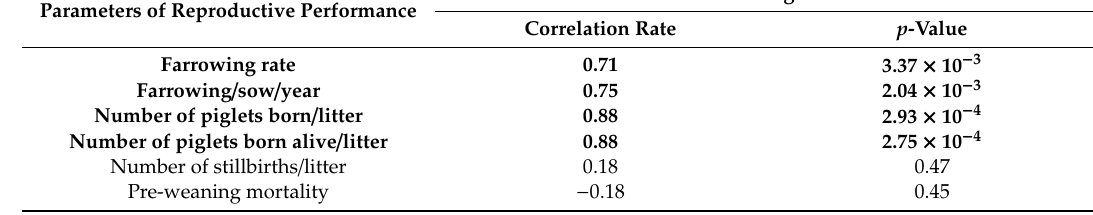
Table 2. Correlation analysis of the number of piglets weaned per sow per year and six reproductive performance